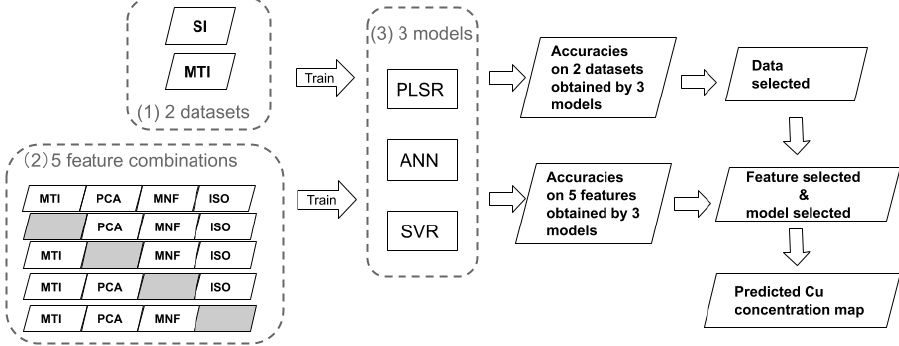
Figure 1. Workflow of the proposed baseline for Cu concentration